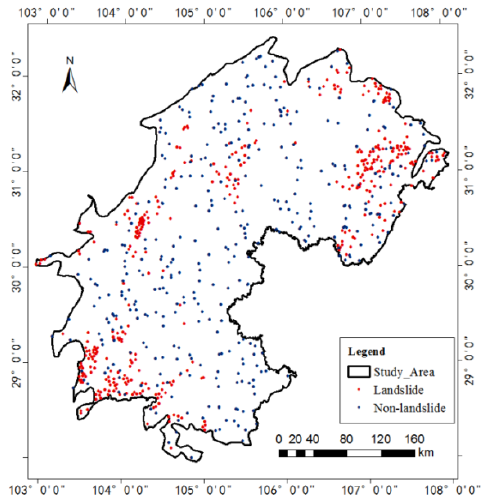
Figure 4. Distribution map of landslides and non-landslides.